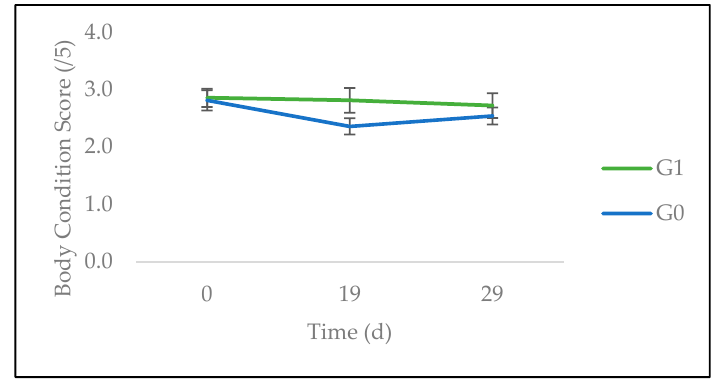
Figure 2. Evolution of the body condition score of sheep fed on C. nlemfuensis hay alone (G0) or G. ulmifolia foliage and C. nlemfuensis hay (G1). d: day.